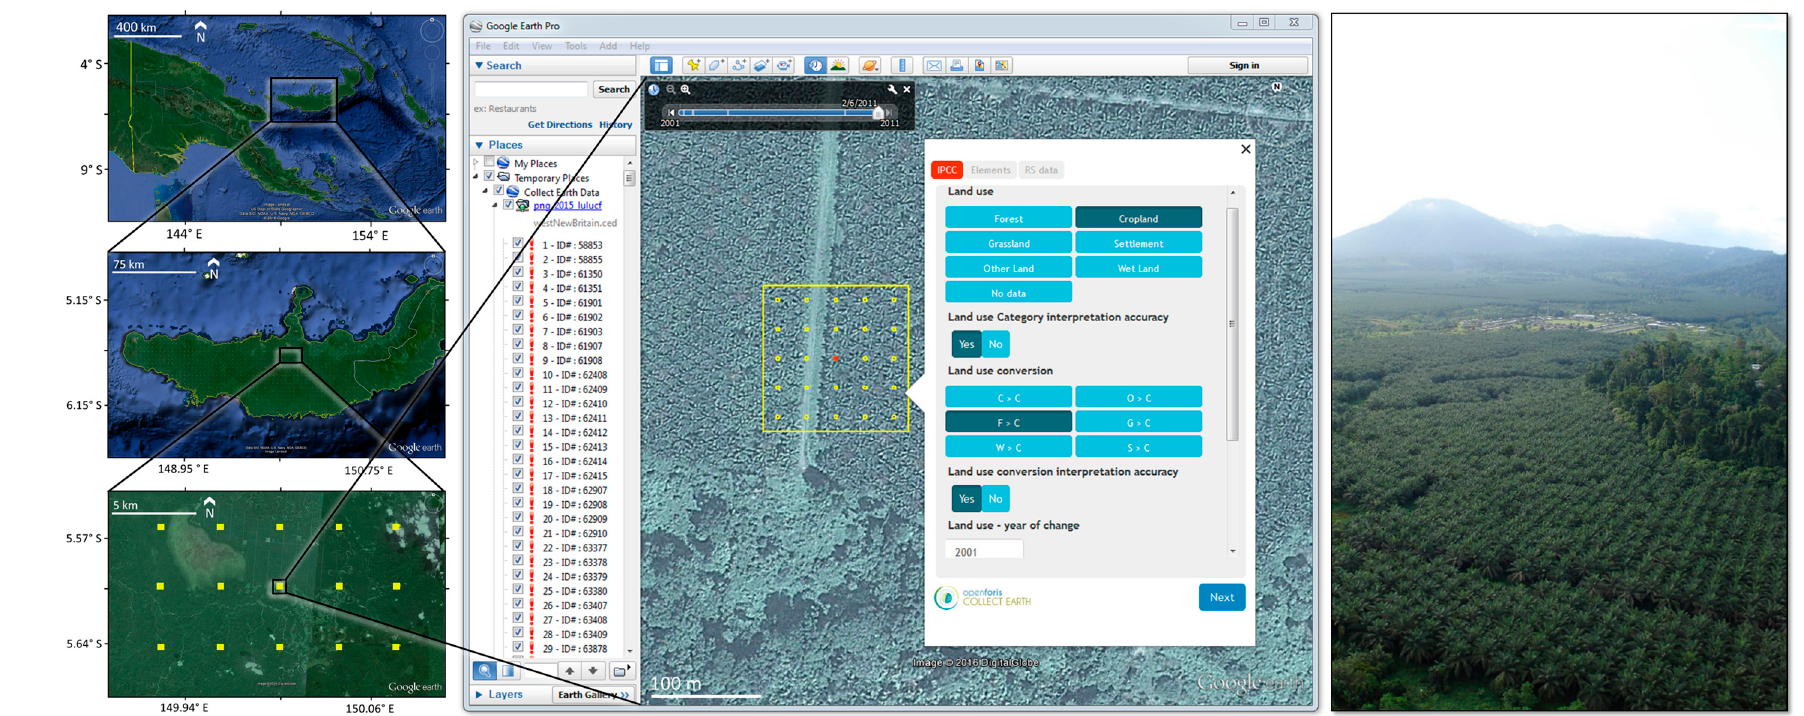
Figure 3. Illustration of sampling design ( left ), project properties ( center ) and a Google Earth Panoramio picture of the plot layout with 25 sampling points ( right ).